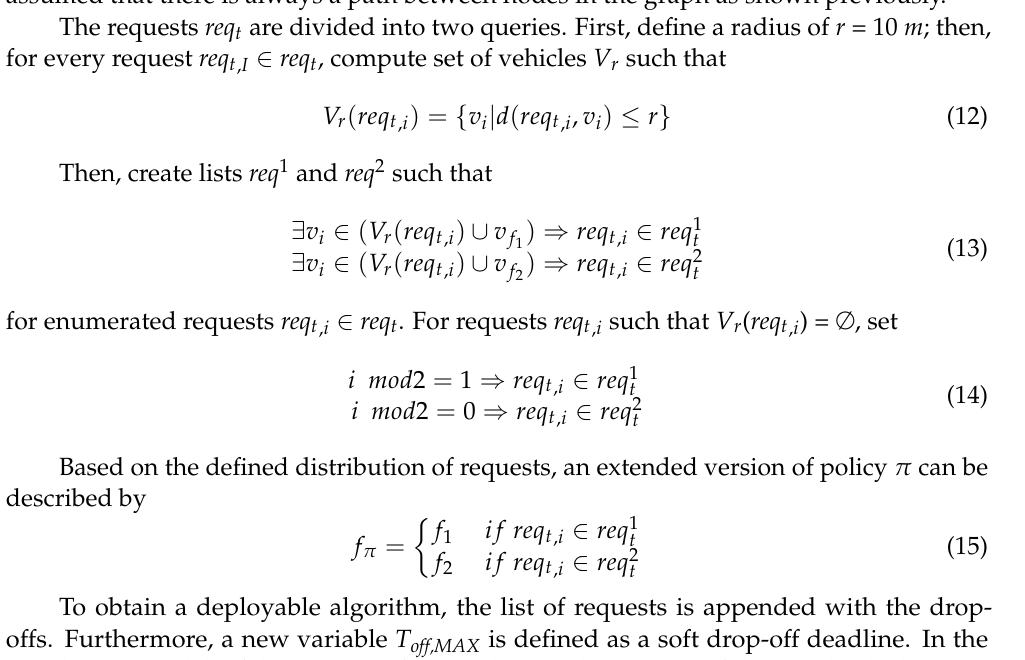
Figure 16. Normalized rewards after training.